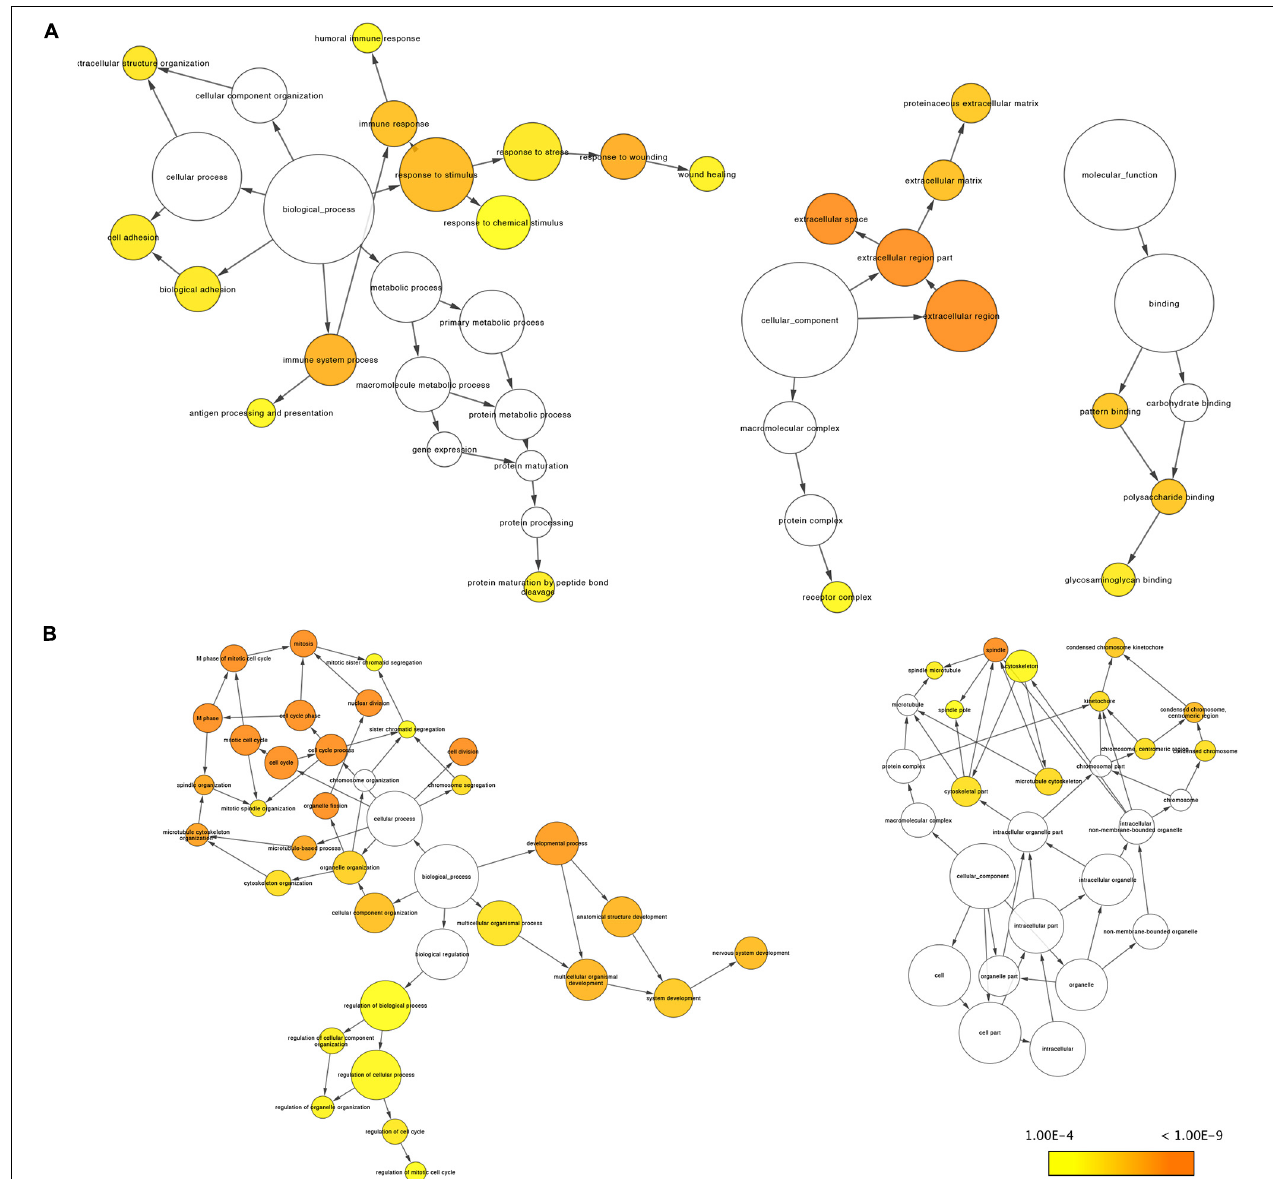
FIGURE 4 | Gene Ontology analyses of robust up-regulated (A) and down-regulated (B) DEGs by BINGO plug-in. There is no enrichment for molecular function in B . The size of the nodes is proportional to the number of genes in that term. Significance decreases from dark orange ( p = 1.00E-9) to yellow ( p =